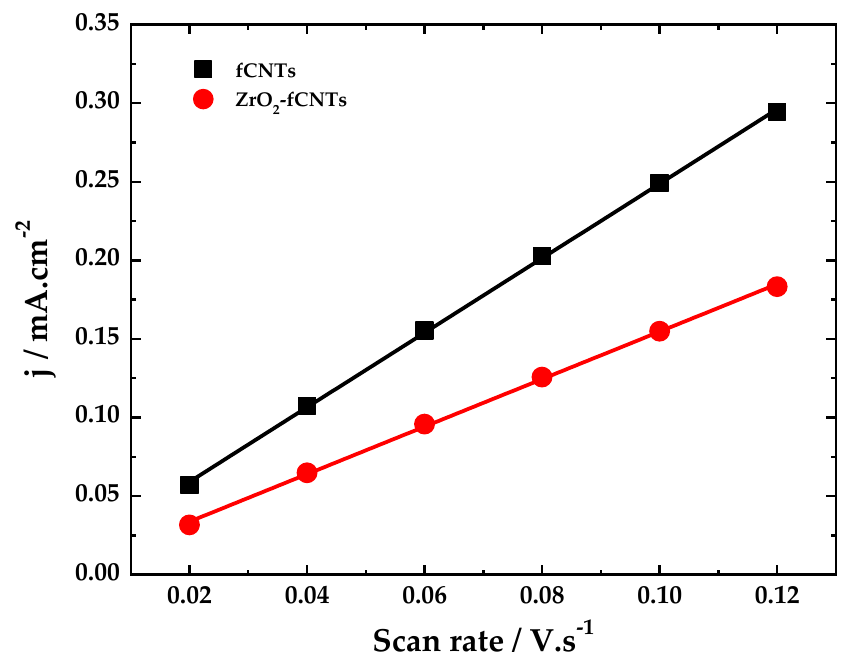
Figure 9. Linear regression of background current density respect to the scan rate (capacitance).